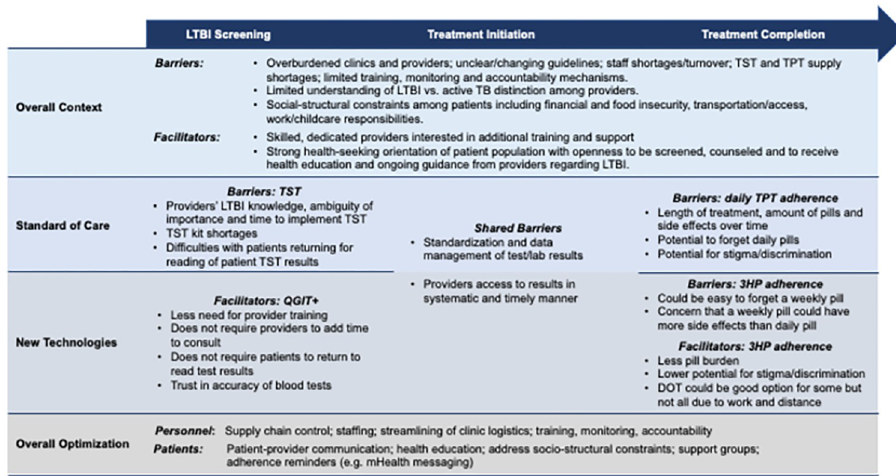
Fig 1. Clinic context, barriers, facilitators, and optimization strategies to improve the LTBI Care Continuum among PLHIV in Brazil via new technologies.